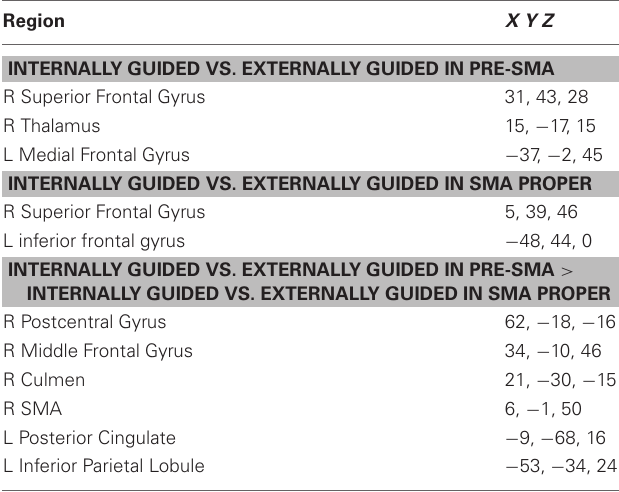
Table 4 | Functional connectivity